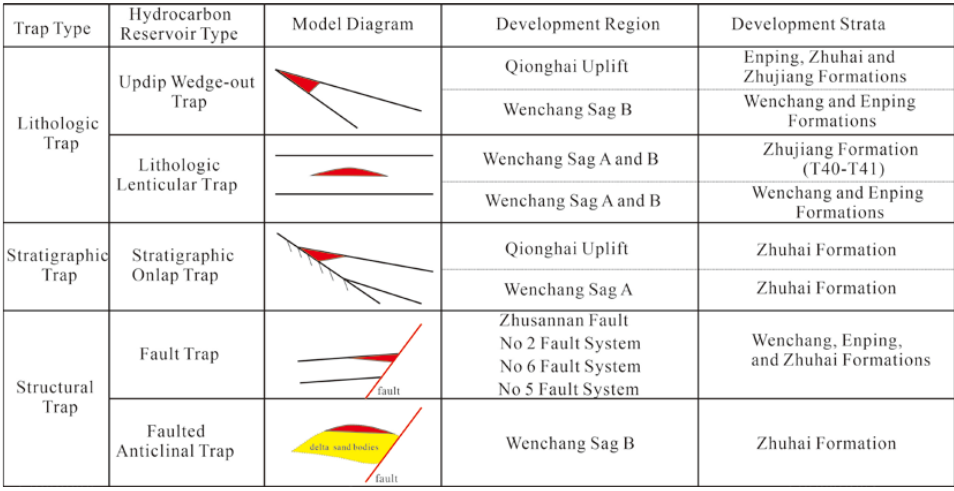
Figure 12. The types of traps and their development strata and regions in the Zhu Ⅲ Depression, PRMB.